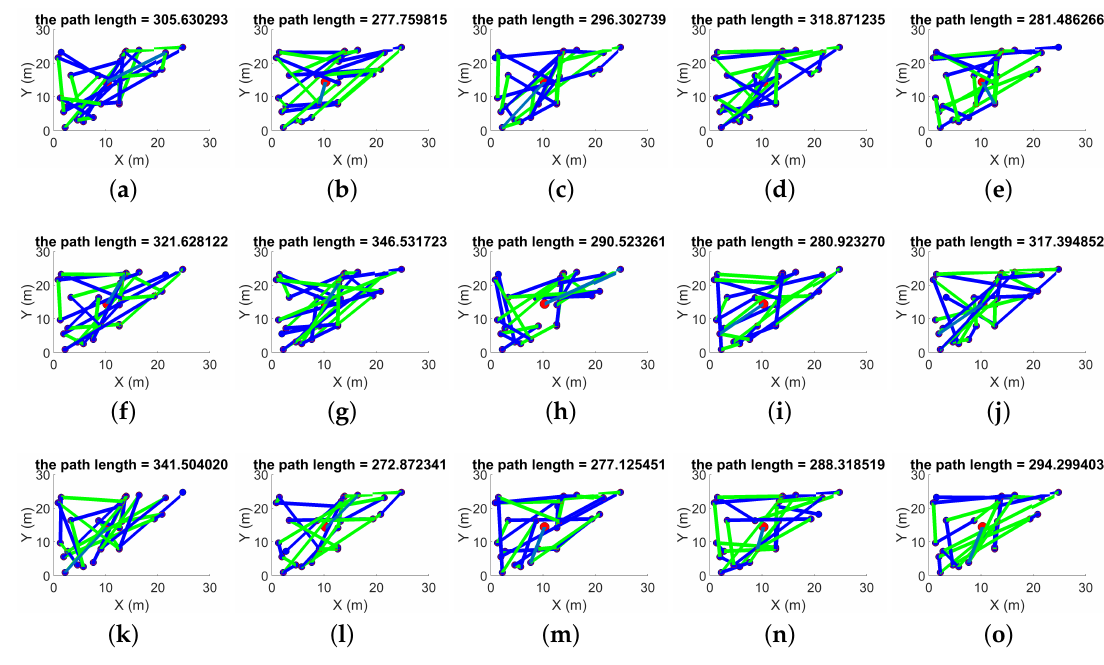
Figure 6. The constructed paths in iterations: 36–50.